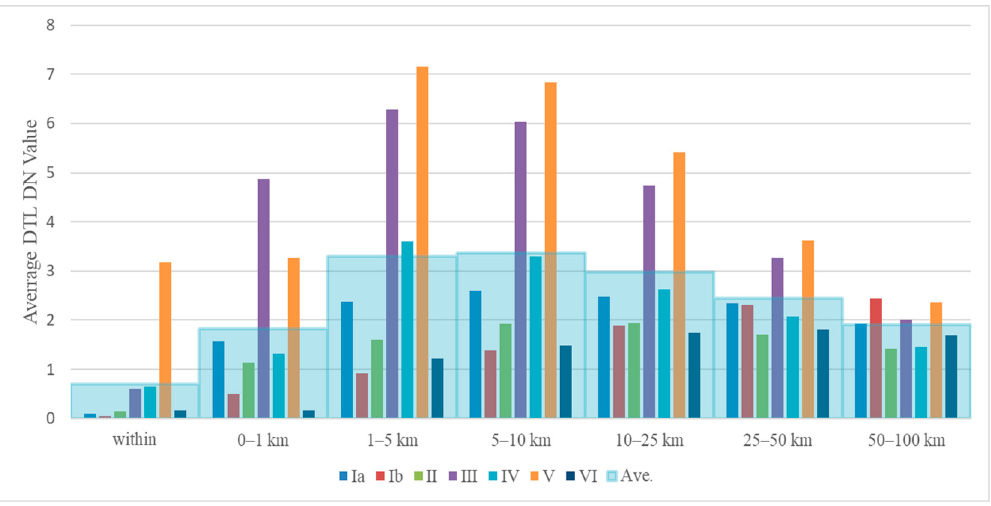
Figure 7. NTL level for each type of PA in buffer zones. Columns with different colors represent different types of PAs. The light blue shadowed areas represents the mean DN values of PAs and buffers.